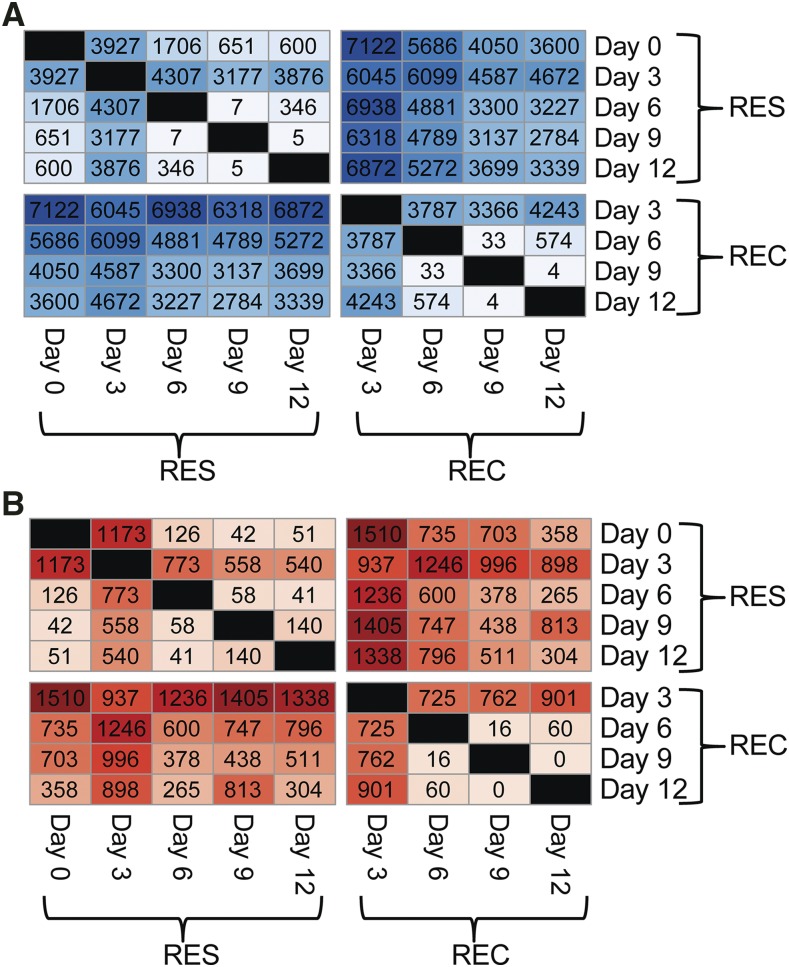
Inflammation induces transient alterations in gene expression and isoform usage in alveolar macrophages. Macrophages were isolated from naïve and LPS-treated mice by lung lavage. Resident and recruited alveolar macrophages were purified, RNA was prepared, and RNAseq was performed. Figures depict: (A) the number of significantly differentially expressed genes (results from pairwise DESeq2 comparisons, counting all genes with an adjusted p-value ≤ 0.05) or (B) the number of genes in which DEXSeq identified significant differences in at least one exon or exon fragment (after accounting for differential expression, adjusted p-value ≤ 0.05) for each pairwise comparison of sample groups. Color shades correspond to the magnitude of the numbers. Darker colors indicate comparisons with more differences (i.e., more differential gene expression or isoform usage). RES refers to resident alveolar macrophages; REC refers to recruited alveolar macrophages. Day 0 refers to resident alveolar macrophages from untreated mice. There is no REC Day 0 sample, because these cells do not arrive until several days after LPS challenge.